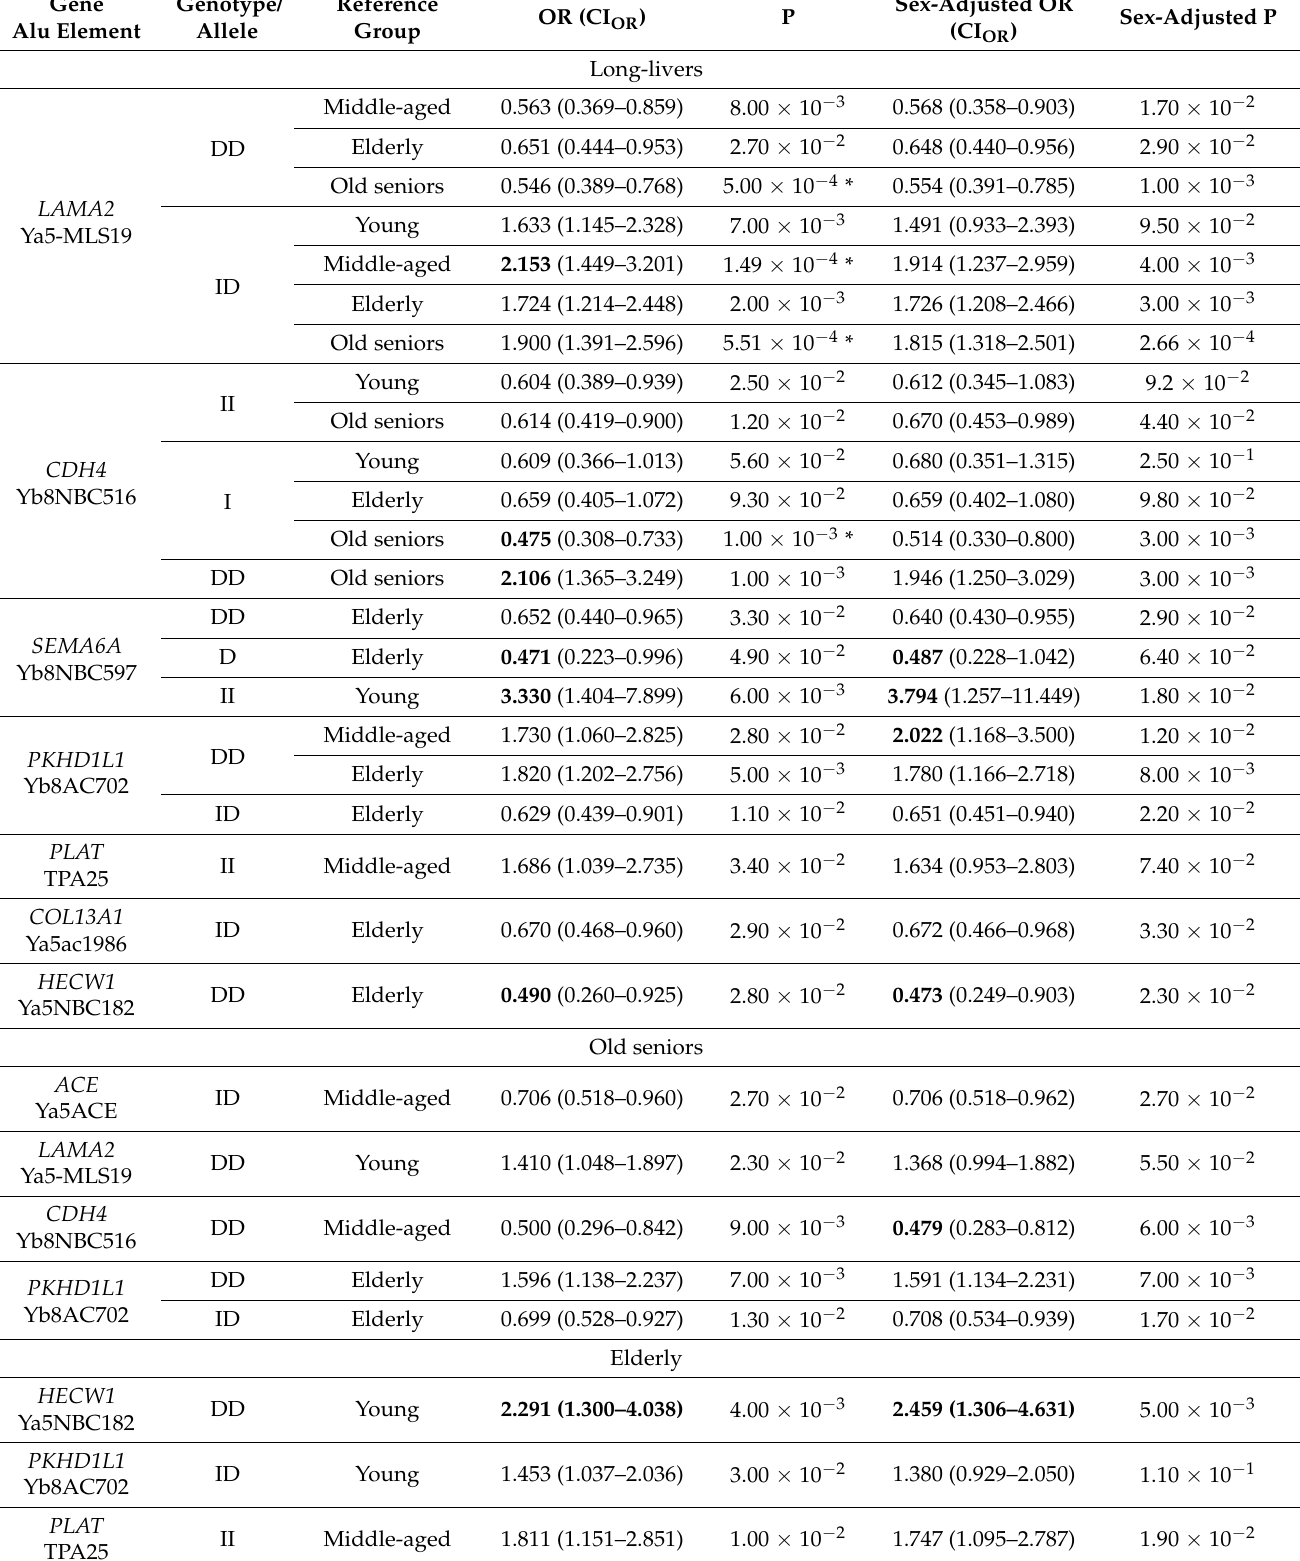
Table 2. Associations of Alu polymorphic loci with